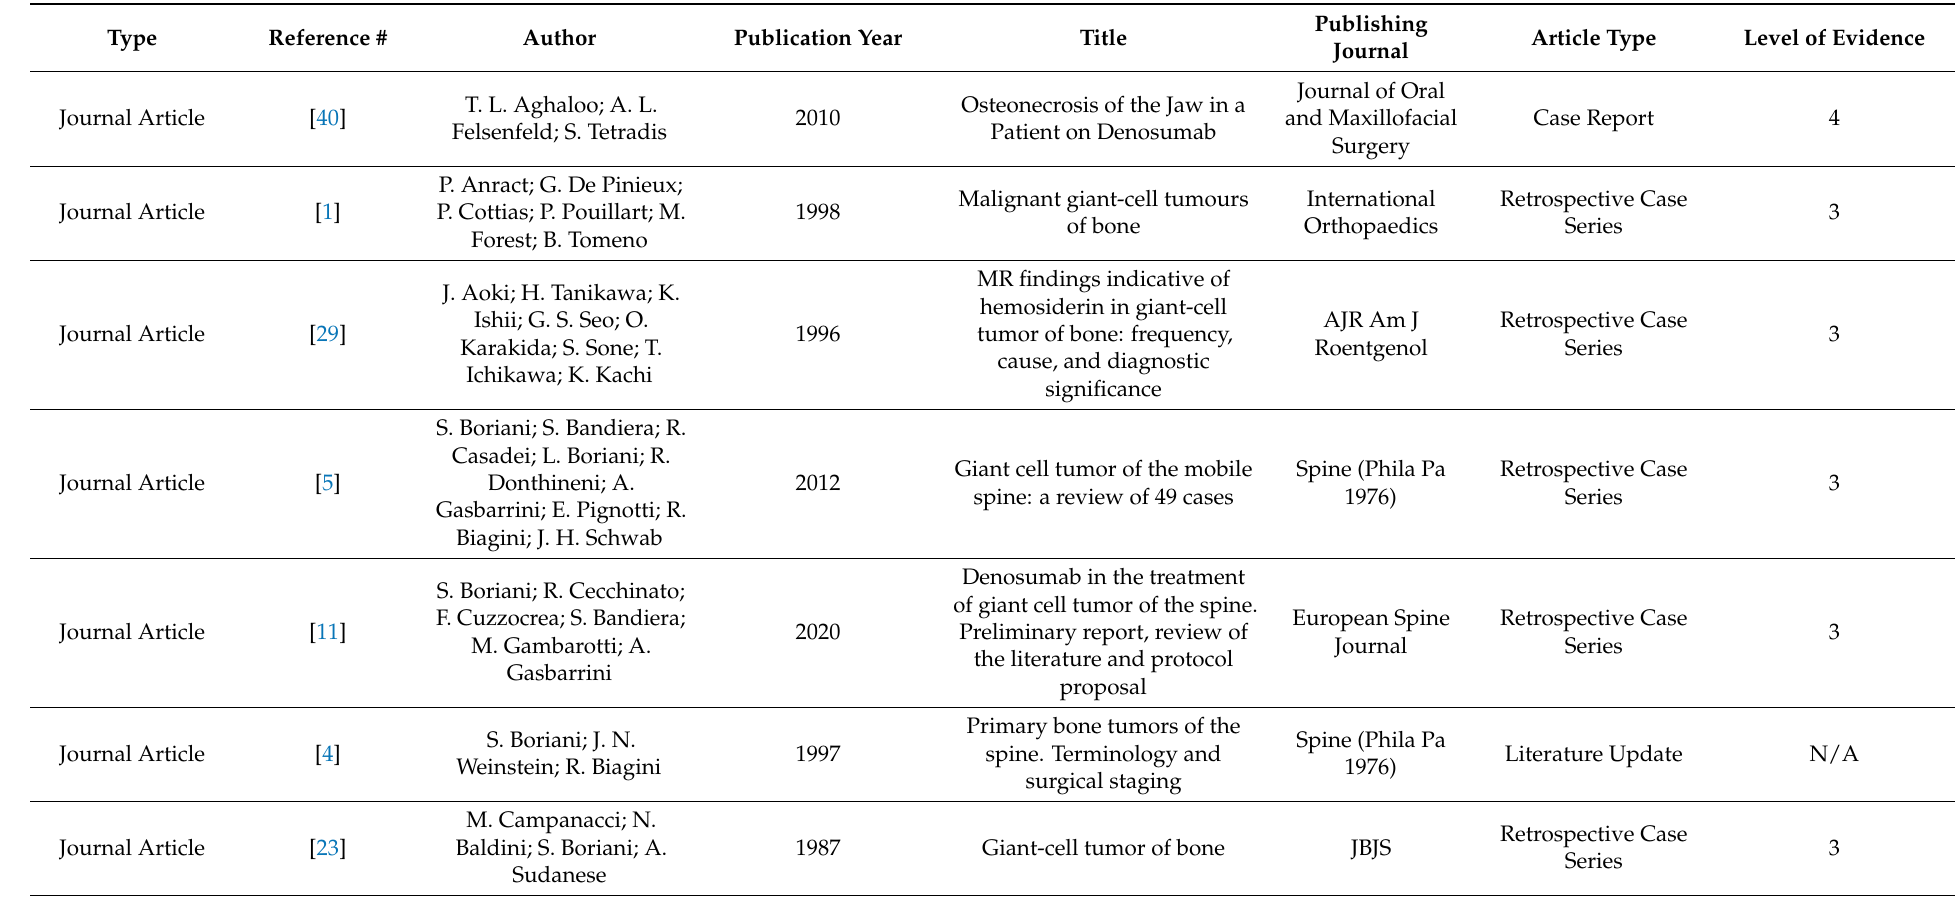
Table A1. Table of all articles cited in the text with level of